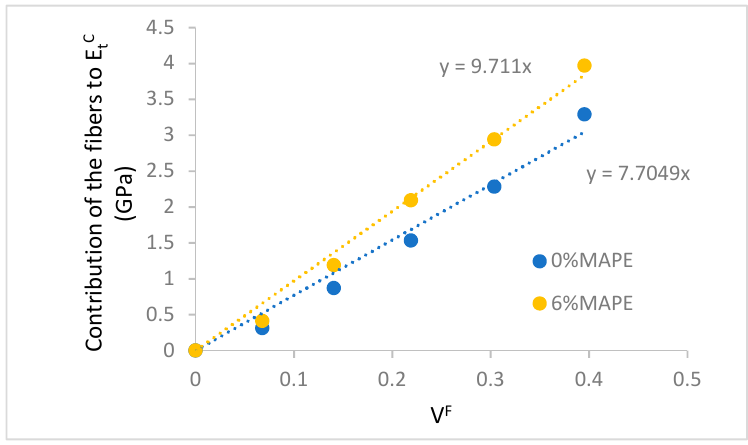
Figure 3. Fiber tensile modulus factor (FTMF) for coupled and uncoupled composites.